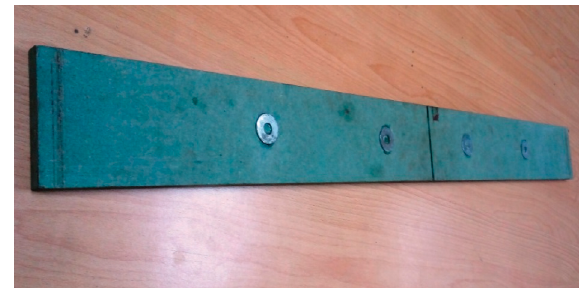
Figure 9: Fatigue test beam model.